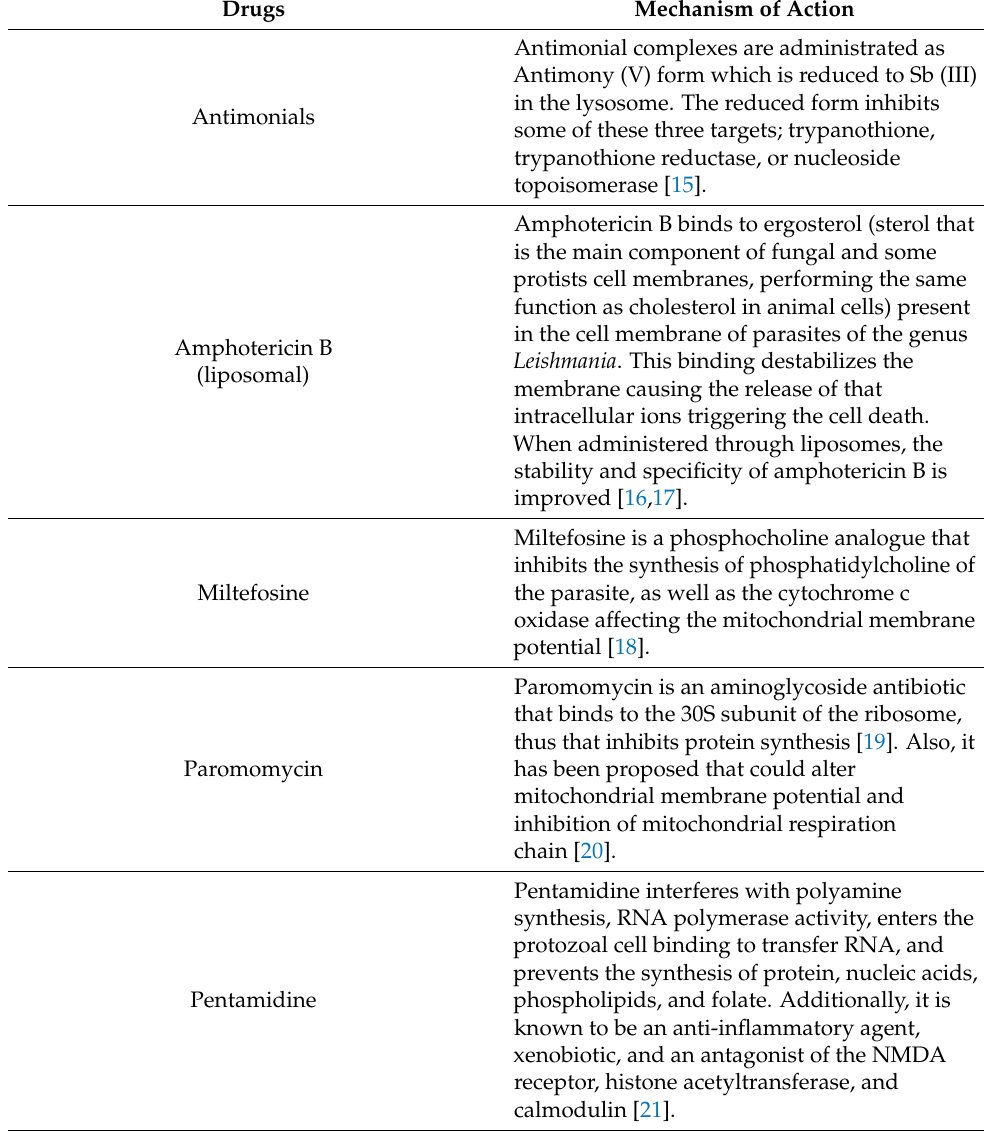
Table 1. Available drugs for the treatment of leishmaniasis and mechanism of